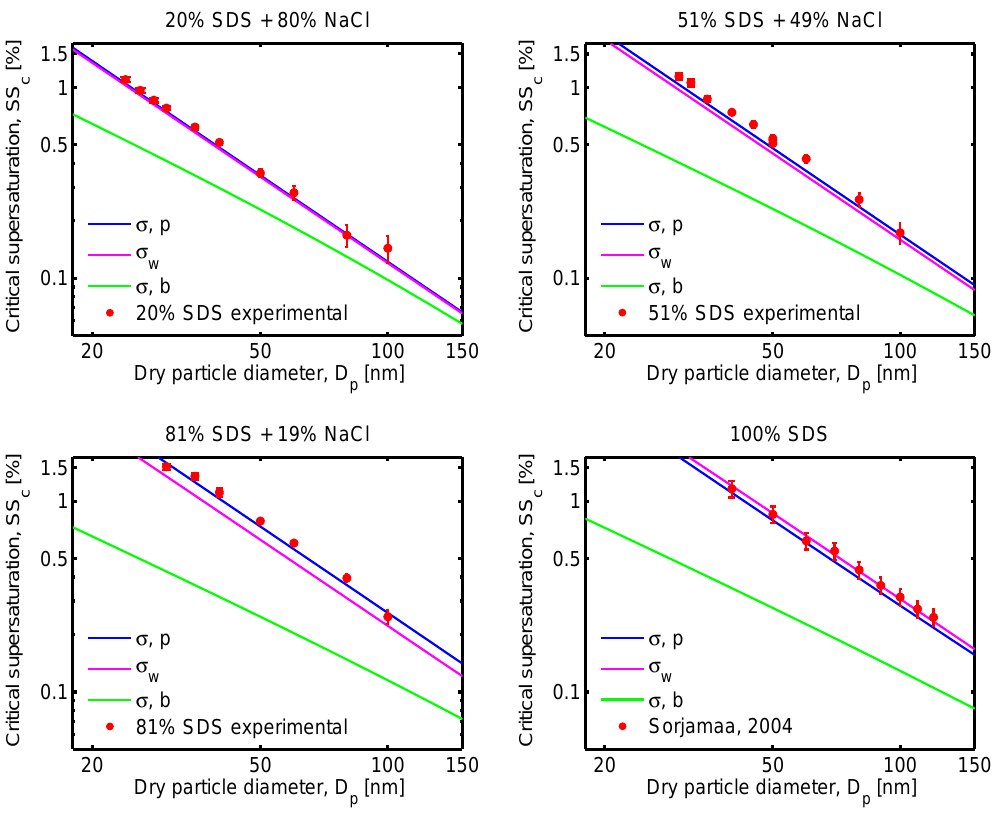
Fig. 5. Critical supersaturations ( SS c [ % ] ) as functions of dry particle diameter ( D p [nm]) for particles with sodium dodecyl sulfate (SDS) in dry mass fractions ( W p, SDS ) of (a) 20%, (b) 51%, and (c) 81%, measured in experiments and modeled with the three different surfactant representations ( σ,p , σ,b , and σ w ). Experimental results from Sorjamaa et al. (2004) for pure SDS are shown in panel (d) and compared to predictions with the model of the current study, using the compound parameters given in Table